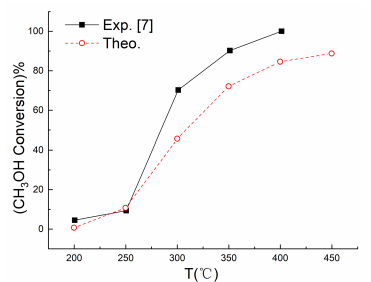
Figure 1. Comparison of microkinetic simulation results with experimental data.